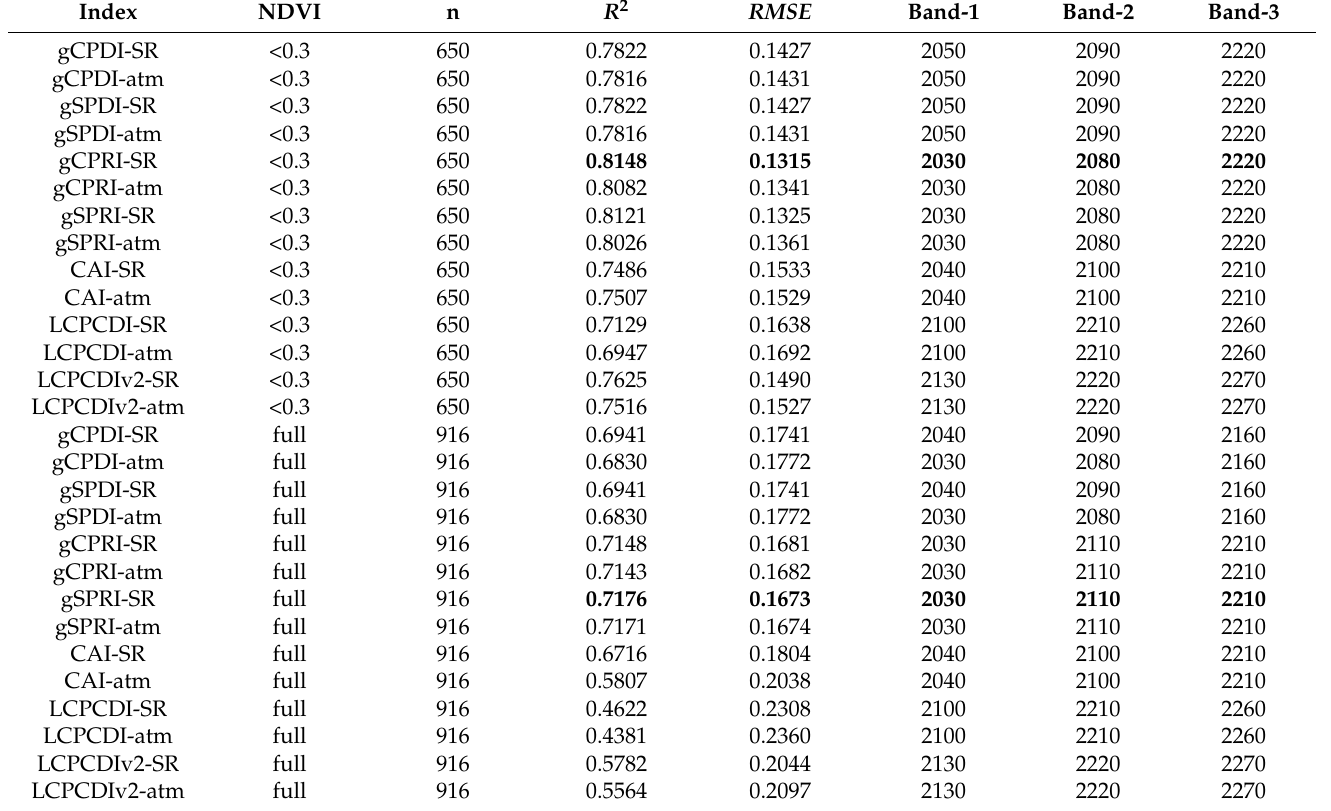
Table 3. Three-band wavelength shift analysis comparison for 10 nm BARC dataset. The highest R 2 values for NDVI < 0.3 (upper rows) and full-NDVI (lower rows) have been bolded. In nearly all cases, spectral bands close to CAI-type bands (2040, 2100, 2210 nm) are top performers. NDVI < 0.3 dataset has n = 650. Full-NDVI dataset has n = 916. Band-1, Band-2, and Band-3 denote the wavelengths with the highest f R estimation performance for both R 2 and RMSE .